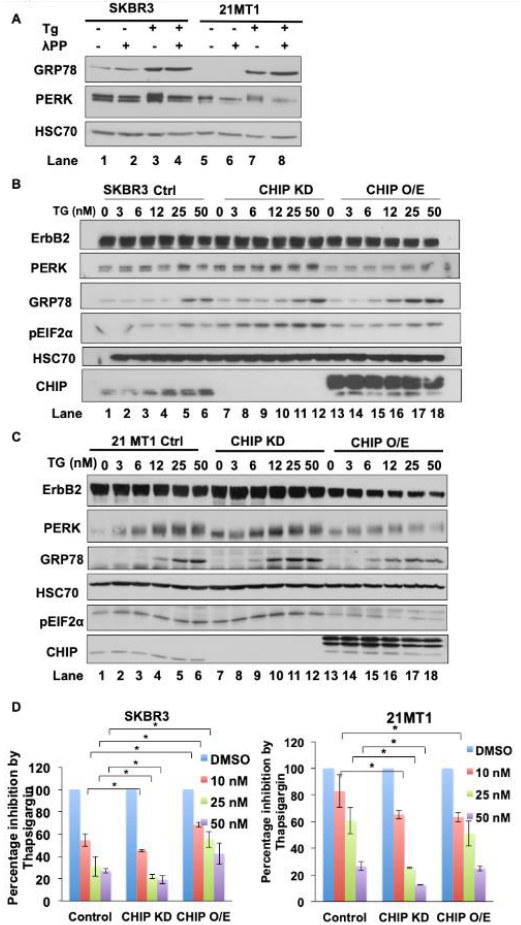
Figure 4. Reduced expression of CHIP sensitizes ErbB2-overexpressing breast cancer cell lines to ER stress. ( A ) SKBR3 and 21MT1 cells were seeded in six-well plates and incubated with ER stress inducer thapsigargin (50nM) for 24 h. Cleared lysates (50 µ g protein/lane) were left untreated or treated with lambda protein phosphatase (400U) for 30 min and then subjected to Western blotting for GRP78, PERK and Hsc70 (loading control). ( B , C ) SKBR3 ( B ) and 21MT1 ( C ) cells were seeded in six-well plates and incubated with indicated concentrations of thapsigargin for 24 h. Cleared lysates (50 µ g/lane) were subjected to Western blotting for ErbB2, GRP78, phospho-eIF2 α , PERK, CHIP and Hsc70 (loading control). ( D ) SKBR3 and 21MT1 cells were seeded in soft agar (0.6% bottom layer, 0.35% top layer) in six-well plates and treated with the indicated concentrations of thapsigargin for 2 weeks. Data represent mean ± SD, n = 3, * p <